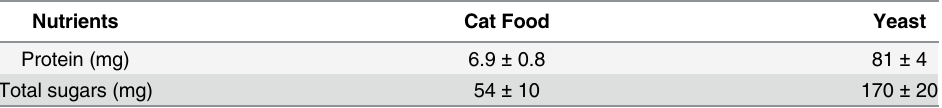
Table 2. Nutritional parameters of the different diets tested for Aedes aegypti larvae. Cat food was used to raise insects in control conditions. Yeast cells ( Saccharomyces cerevisiae ) were grown in liquid Sabourad media and offered to larvae as described. Figures correspond to protein and sugar quantities which are present in the amounts of food used to raise A. aegypti adults from eggs. See Material and Methods for details.